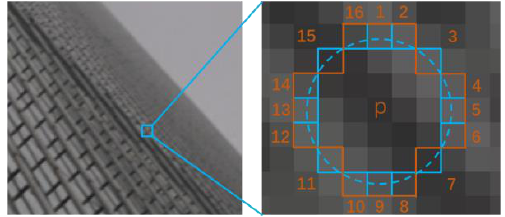
Figure 2. oFAST feature point